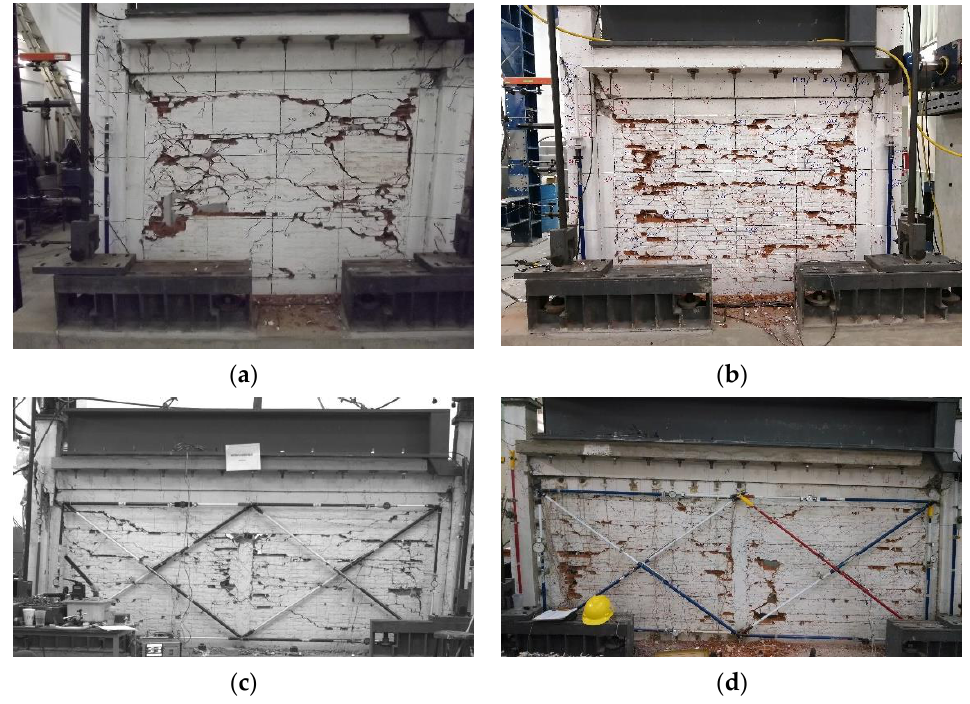
Figure 9. Crack pattern. ( a ) MD3N_L75; ( b ) MD3NRH_L75; ( c ) MD3N_L41; ( d ) MD3NRH_L41.